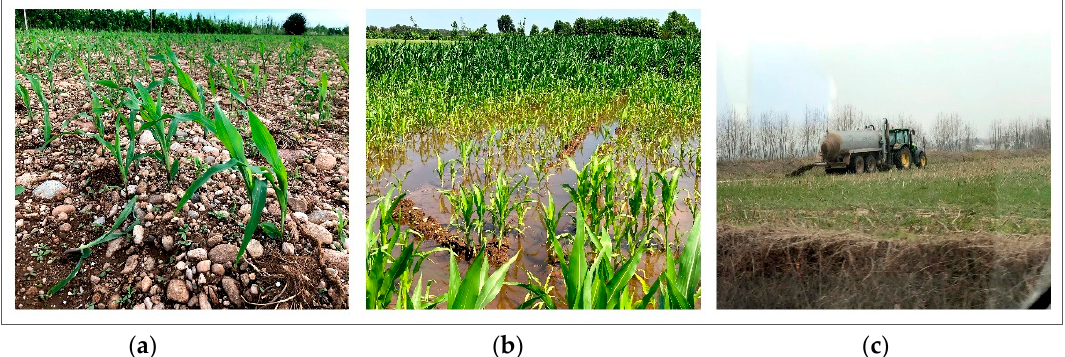
Figure 2. Agricultural practices in our study area: ( a ) maize cultivation on permeable soils; ( b ) flood irrigation over maize fields; ( c ) manure spreading after crops harvesting.